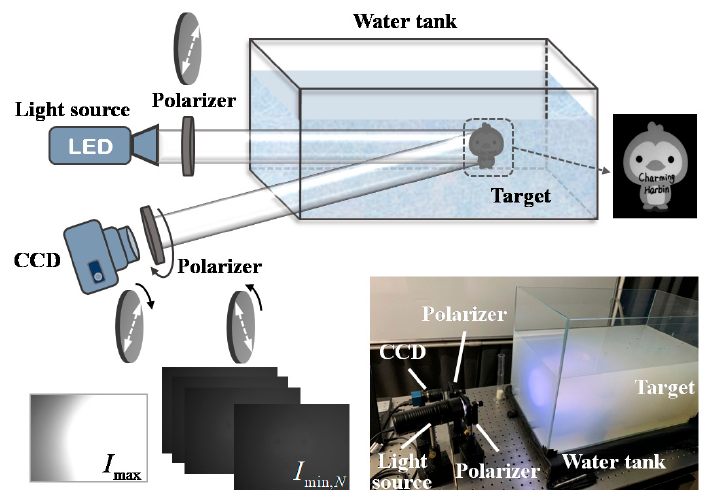
Figure 4. Underwater polarization imaging experimental setup.